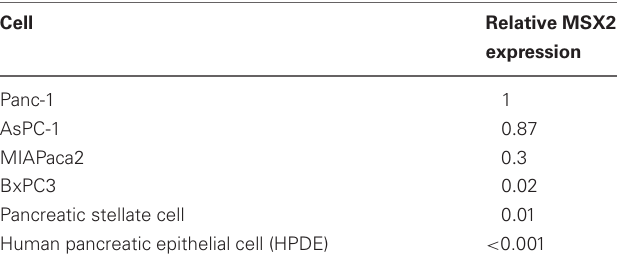
Table 1 | Relative expression of MSX2 in cultured pancreatic cells (Satoh et al., 2008a, 2010). Cell Relative MSX2